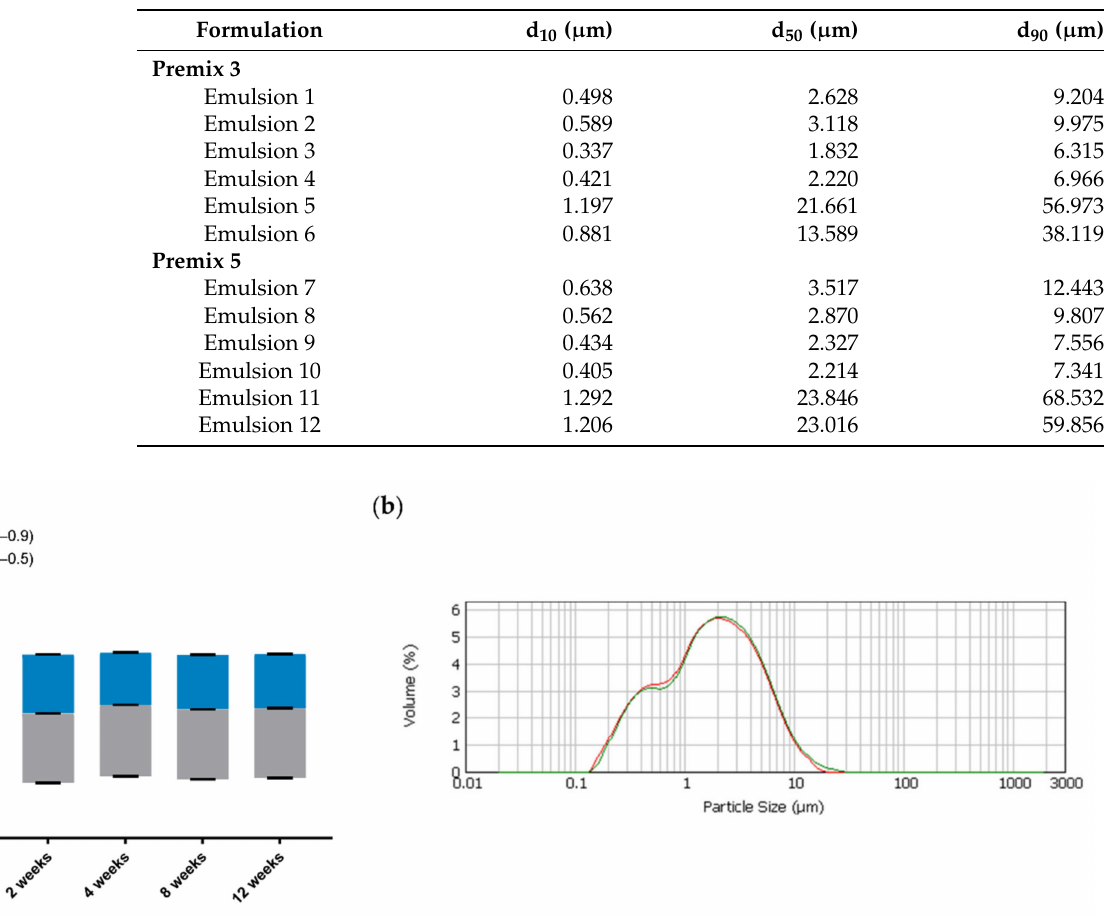
Table 6. Results of the droplet size determination (d 10 , d 50 and d 90 values) 24 h after manufacturing; mean ± SD, n = 3.